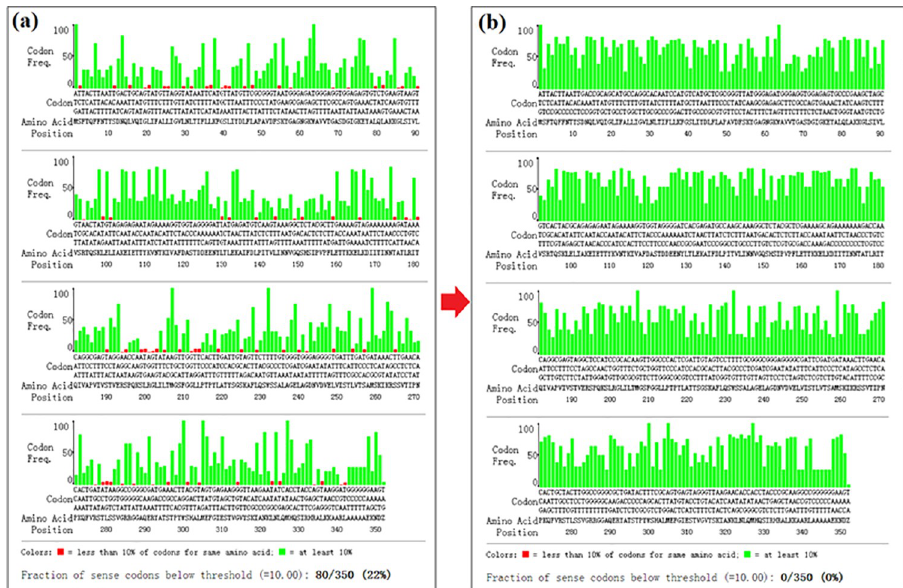
Fig 1. Codon optimization of the akr gene. (a) Before optimization; (b) After optimization.